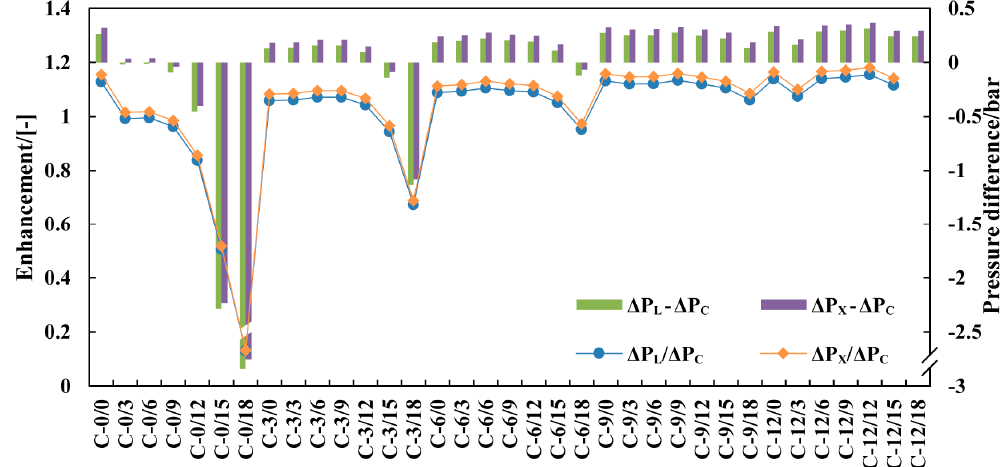
Figure 16. Improvement over bend region and bend volume (0 ≤ r ≤ 18).